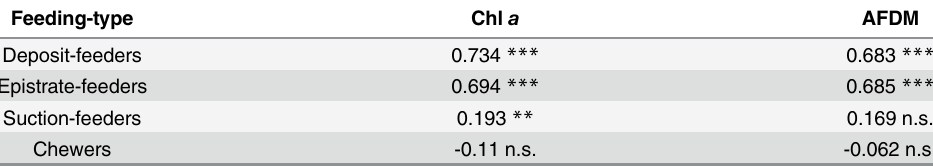
ρ testing the statistical dependence of the relative occurrence of nematode feeding types on the amount of chlorophyll a (Chl a ) and ash-free dry (organic) material (AFDM) in the periphyton of Lake Erken. Signi fi cance level ( p ): n.s.: not signi fi